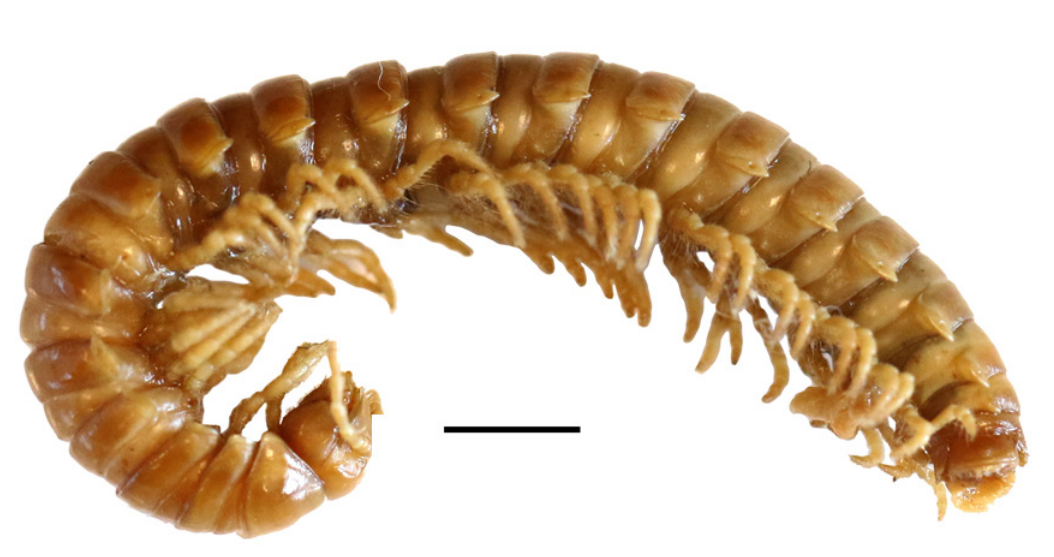
Fig. 8. Pogoro alopias Rosenmejer & Enghoff sp. nov., holotype, ♂ (NHMD 621670). Scale bar: 5